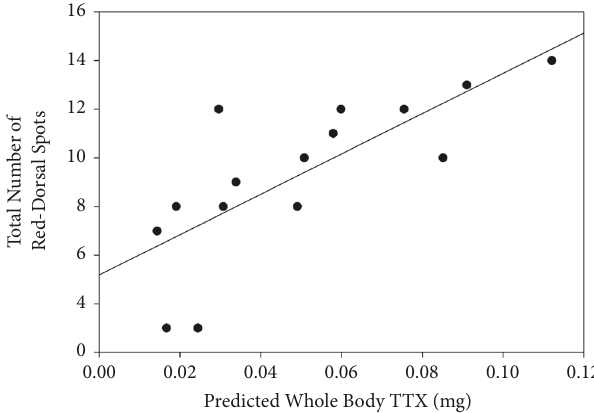
Figure 2: Regression of the total number of red dorsal spots and the predicted whole body TTX (mg) of Eastern newt ( Notophthalmus viridescens ) efts. Efts with more red dorsal spots possess greater concentrationsof TTX in the skin (F = 17.5, R 2 = 0.57, P = 0.001). The whole body TTX estimate for each eft was the average of the paired estimates from the punch containing and lacking a red dorsal